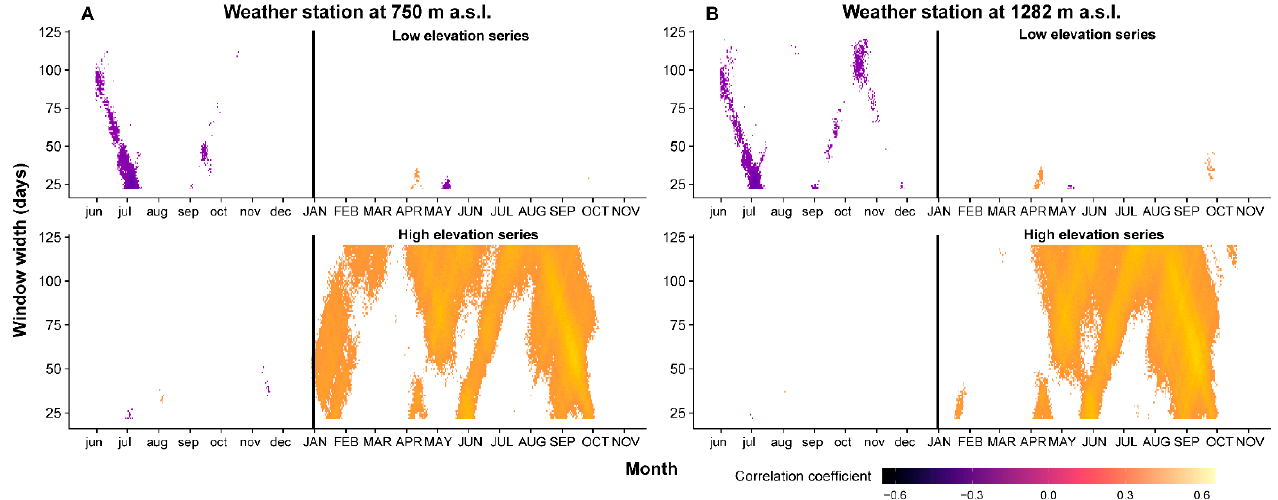
Figure 4. Correlation between BI residual index chronologies and cumulative daily temperature from valley weather station (Joseni) ( A ) and from up-hill weather station (Bucin) ( B ) (vertical black line represents the limit between previous (with lowercase) and current (with uppercase) year).